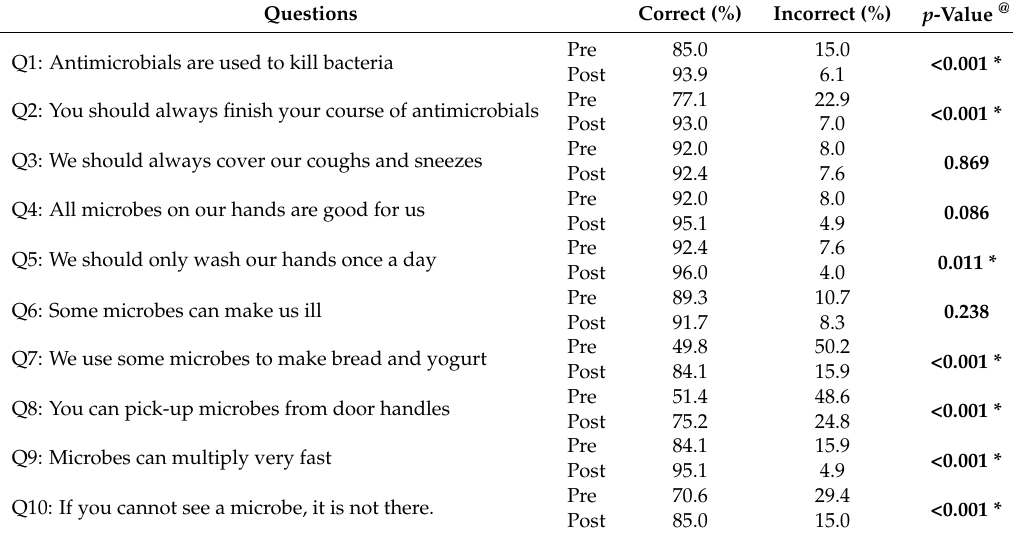
Table 2. Comparison of pre and post percentage scores of participating